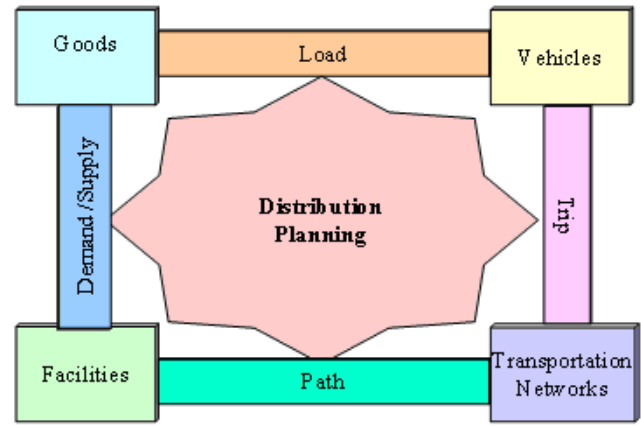
Figure 2: The distribution planning